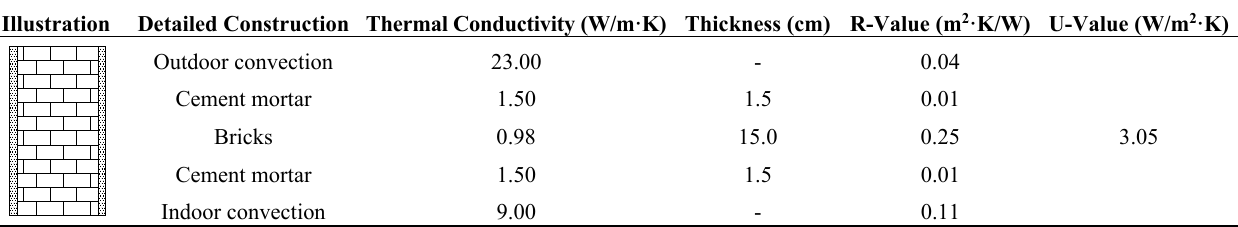
Table 1. Detail of the exterior brick wall and thermal properties of each layer of material